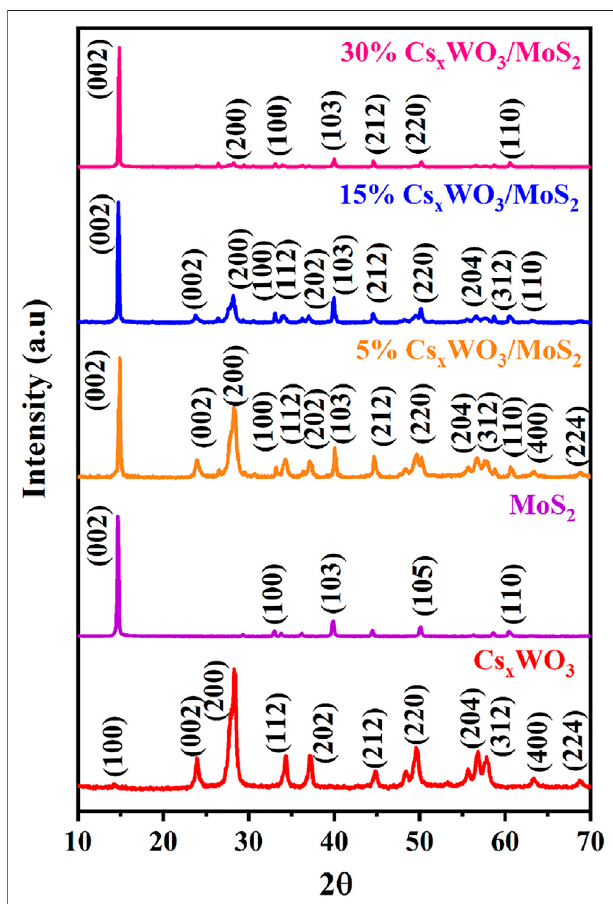
FIGURE5| XRDresultsofpureCs x WO 3 ,pureMoS 2 ,anddifferentratios of Cs x WO 3 /MoS 2 nanocomposites.